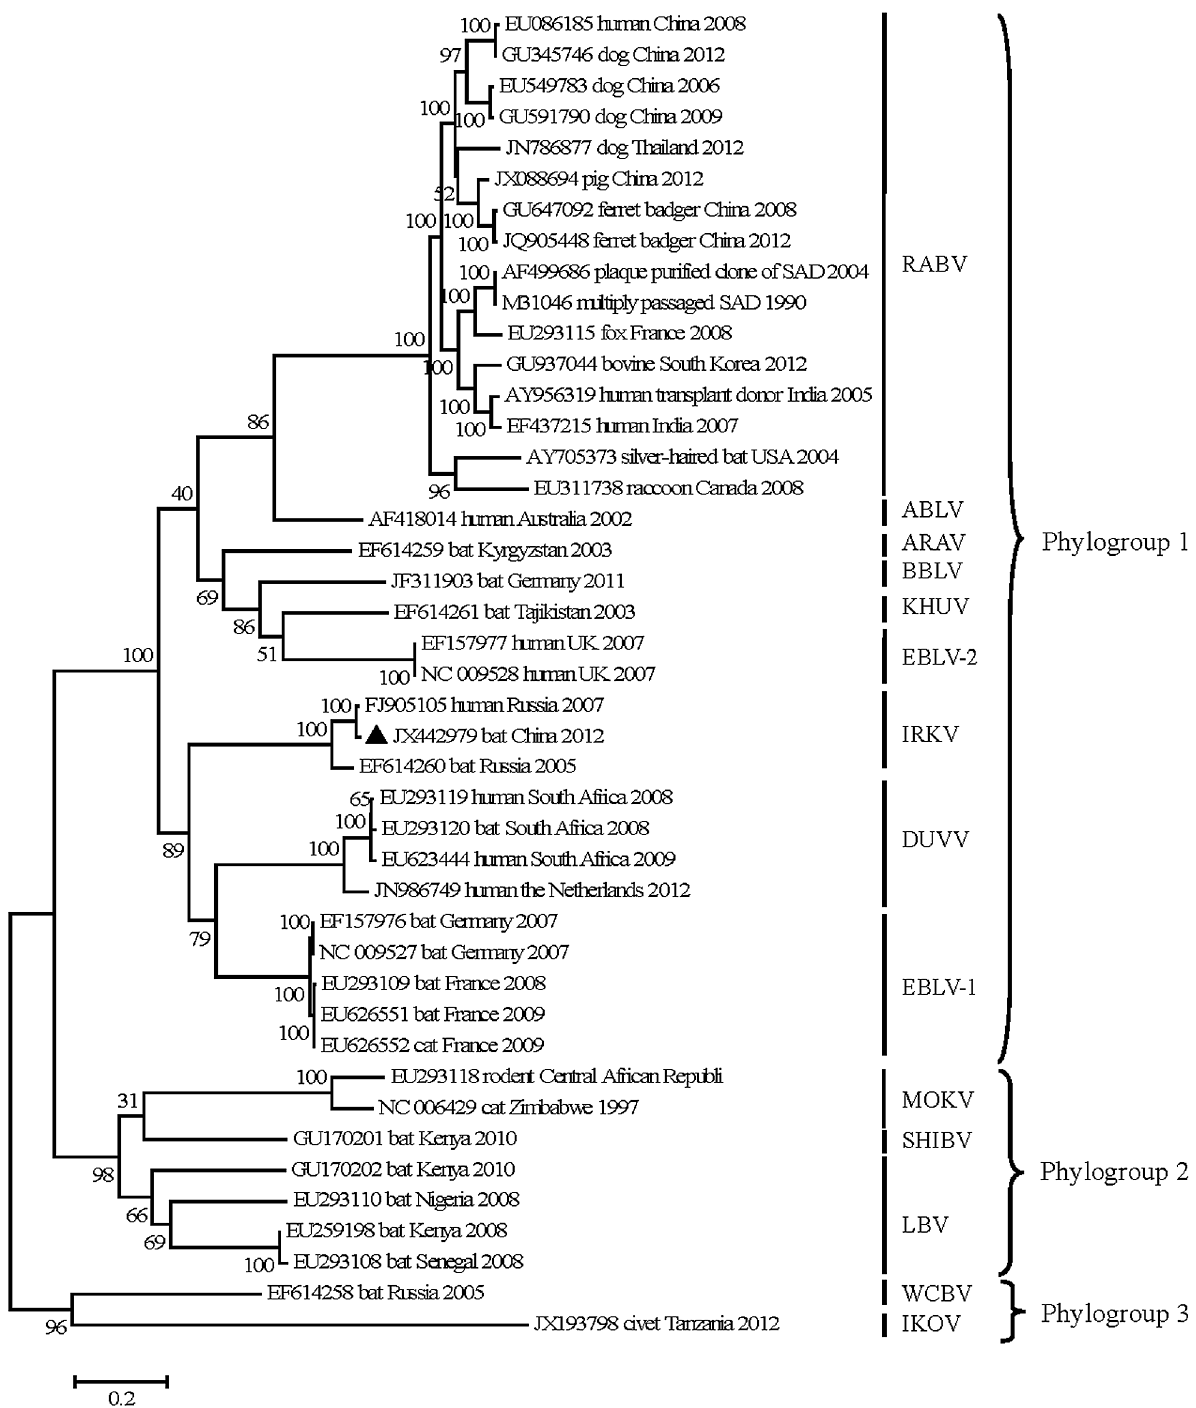
Figure 1. Maximum likelihood of the lyssavirus-rooted phylogenetic tree based on the complete N sequences. The isolate, IRKV- THChina12, is marked using black triangle. Bootstrap values are presented as percentages for key nodes on the tree, and branch lengths are indicated using a scale bar. EBLV-1: European bat lyssavirus-1; DUVV: Duvenhage virus; IRKV: Irkut virus; ARAV: Aravan virus; BBLV: Bokeloh bat lyssavirus; KHUV: Khujand virus; EBLV-2: European bat lyssavirus-2; ABLV: Australian bat lyssavirus; RABV: rabies virus; WCBV: West Caucasian bat virus; SHIBV: Shimoni bat virus; MOKV: Mokola virus; LBV: Lagos bat virus; and IKOV: Ikoma lyssavirus.